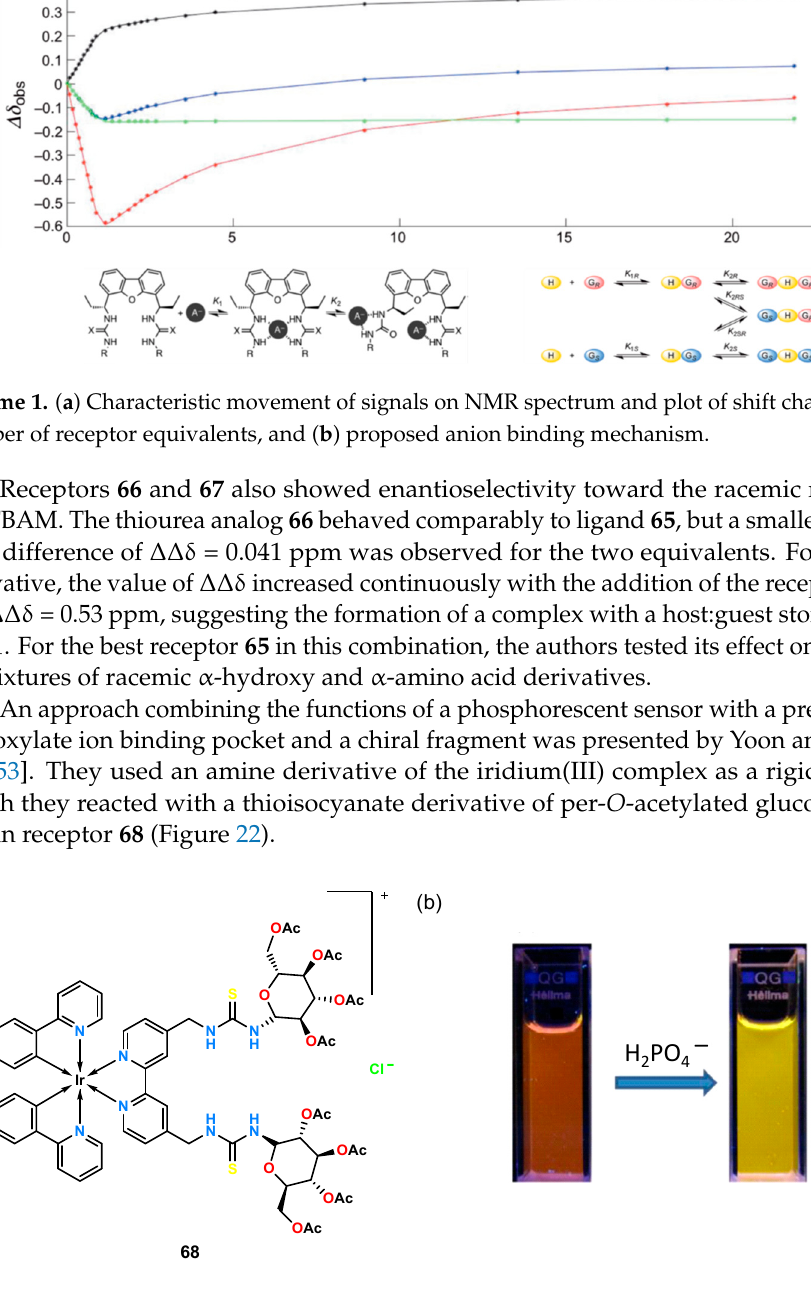
Figure 22. ( a ) Iridium receptor 68 and ( b ) phosphorescence changes by naked eye upon the addition of TBA-H 2 PO 4 to CH 3 CN.